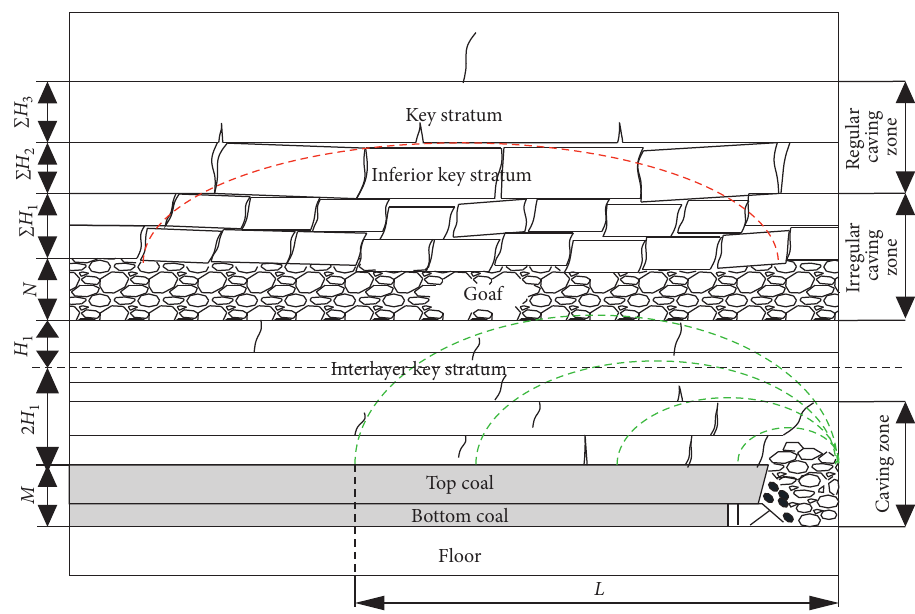
Figure 5: Stability of arch structure under the condition of middle and upper interlayer key